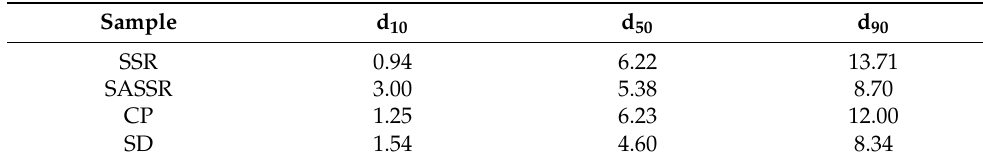
Figure 4. Particle size distributions of the different powders (red—SSR; blue—SASSR; yellow—SD; green—CP). While the SASSR powder shows a quite narrow distribution, the three other powders have a bimodal distribution with one plateau below 1 µ m and one between 3 and 10 µ m. Table 2. Parameters of the particle size distribution for the different samples determined by laser- scattering